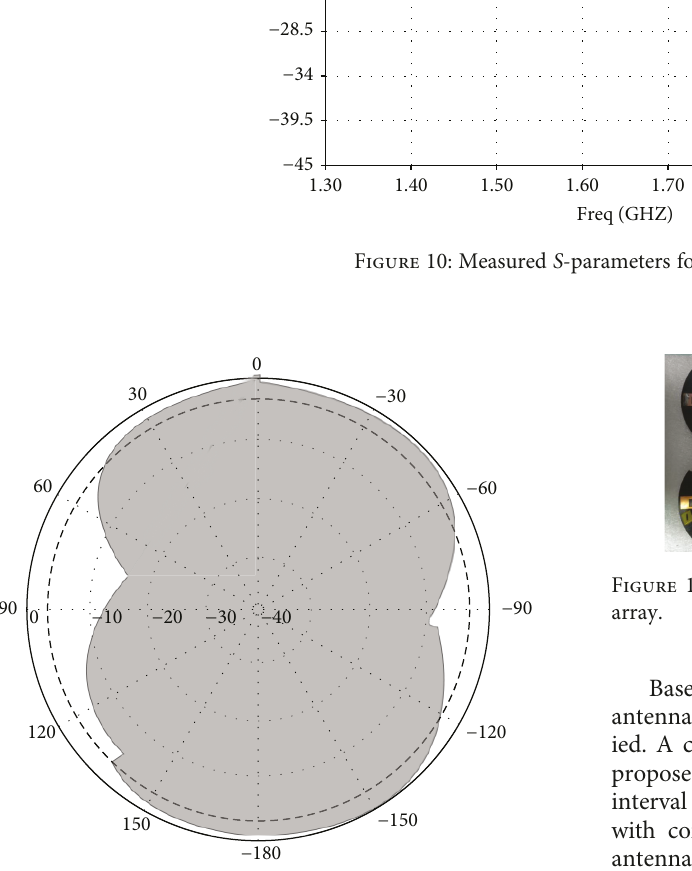
Figure 11: Measured radiation pattern (gain) of one antenna unit ( S , dB).